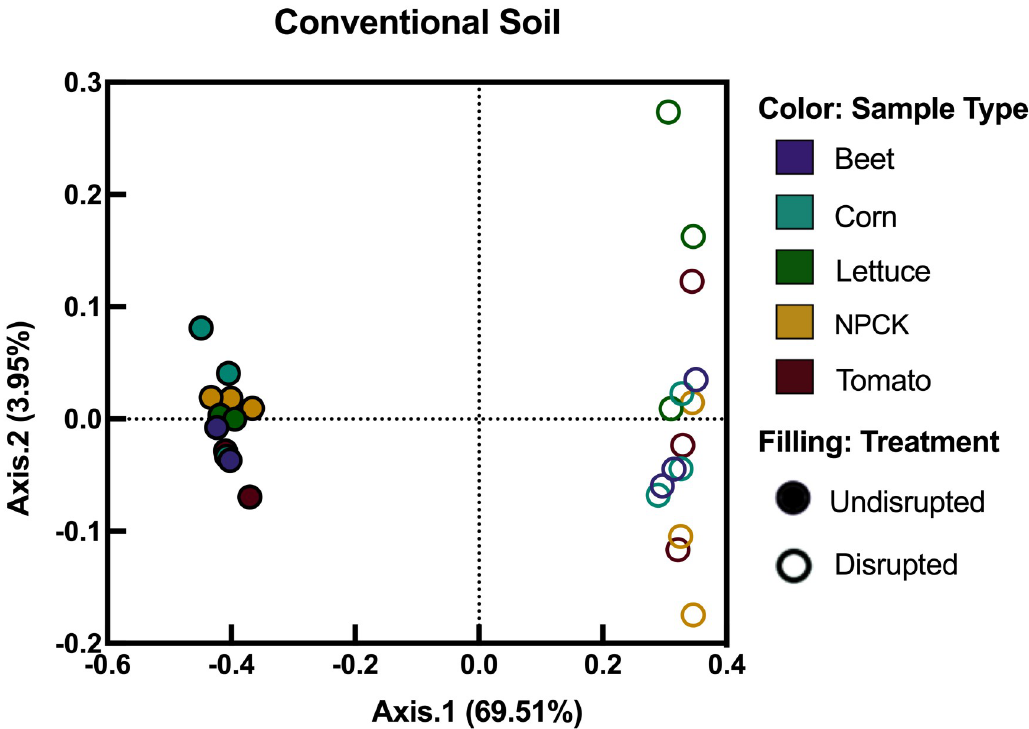
Fig 4. Principal coordinate analyses (PcoA) of rhizobacterial communities after crop growth in undisrupted and disrupted conventional agroecosystem soils. Colored circles indicate samples treated with disruption, whereas hollow circles indicate undisrupted soils, respectively. Purple, teal, green, yellow, or red color represents rhizospheric samples from beet, corn, lettuce, NPCKs or tomato samples, respectively. Figure created using GraphPad’s Prism (Vers.